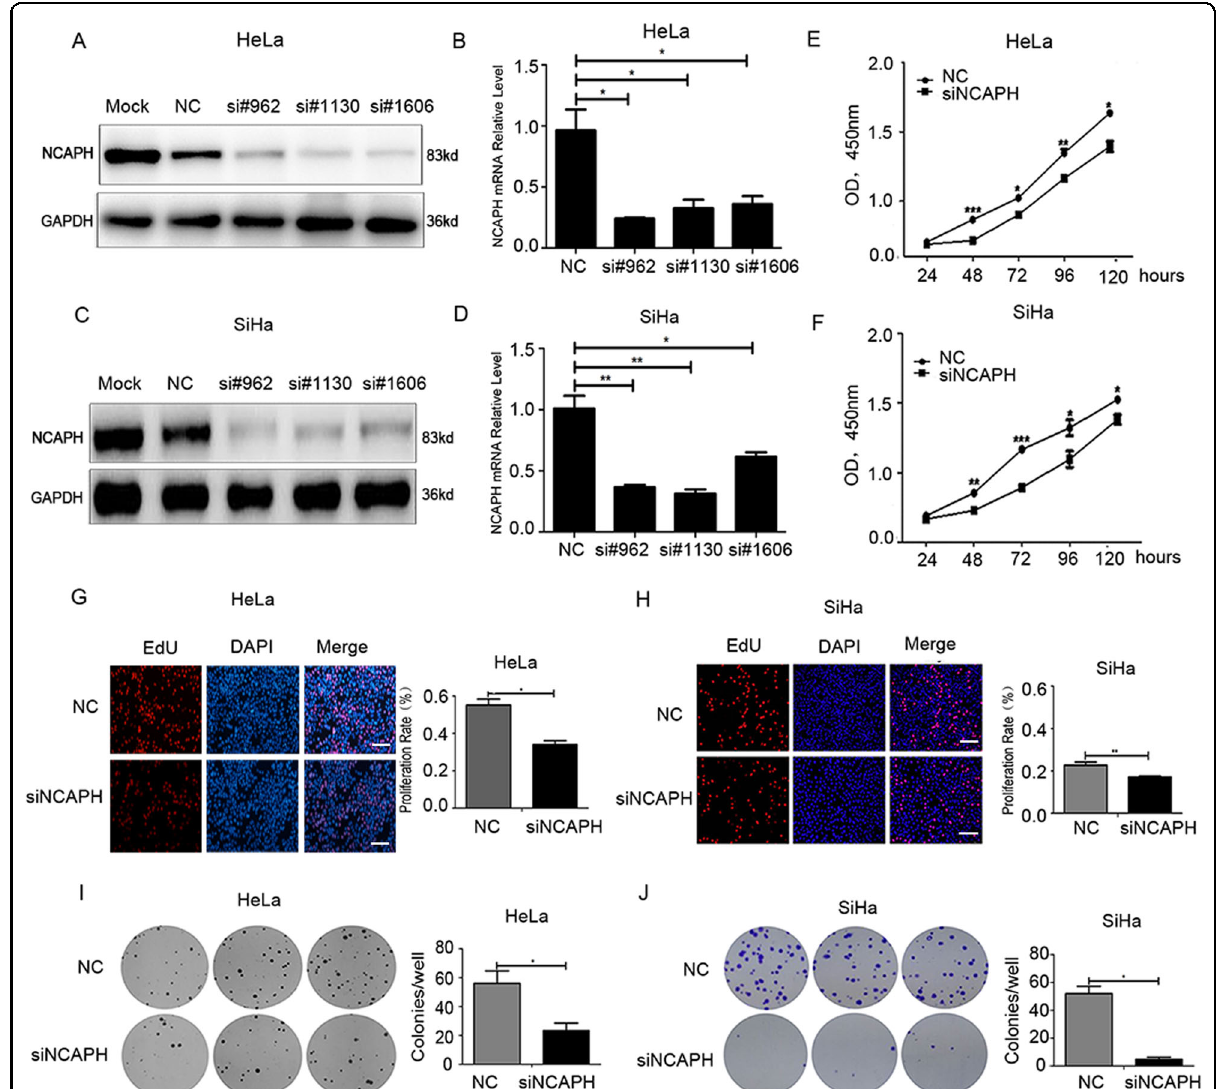
ef fi ciency of three NCAPH siRNAs was assessed by Western blot analysis and real-time quantitative PCR. E – H CCK-8 and EdU assays showed that the proliferation ability of cervical cancer cells decreased signi fi cantly when transfected with NCAPH siRNA. Scale bars, 100 μ m. I , J Colony formation assay showed that the capacity of the cells to form colonies was signi fi cantly reduced with the knock-down of NCAPH. NC, cells treated with negative control siRNA; siNCAPH, cells treated with siRNA targeting NCAPH gene. Results shown are representative of triplicate experiments. Data are presented as mean ± SD ( n = 3). * represents p < 0.05, ** represents p < 0.01, *** represents p <